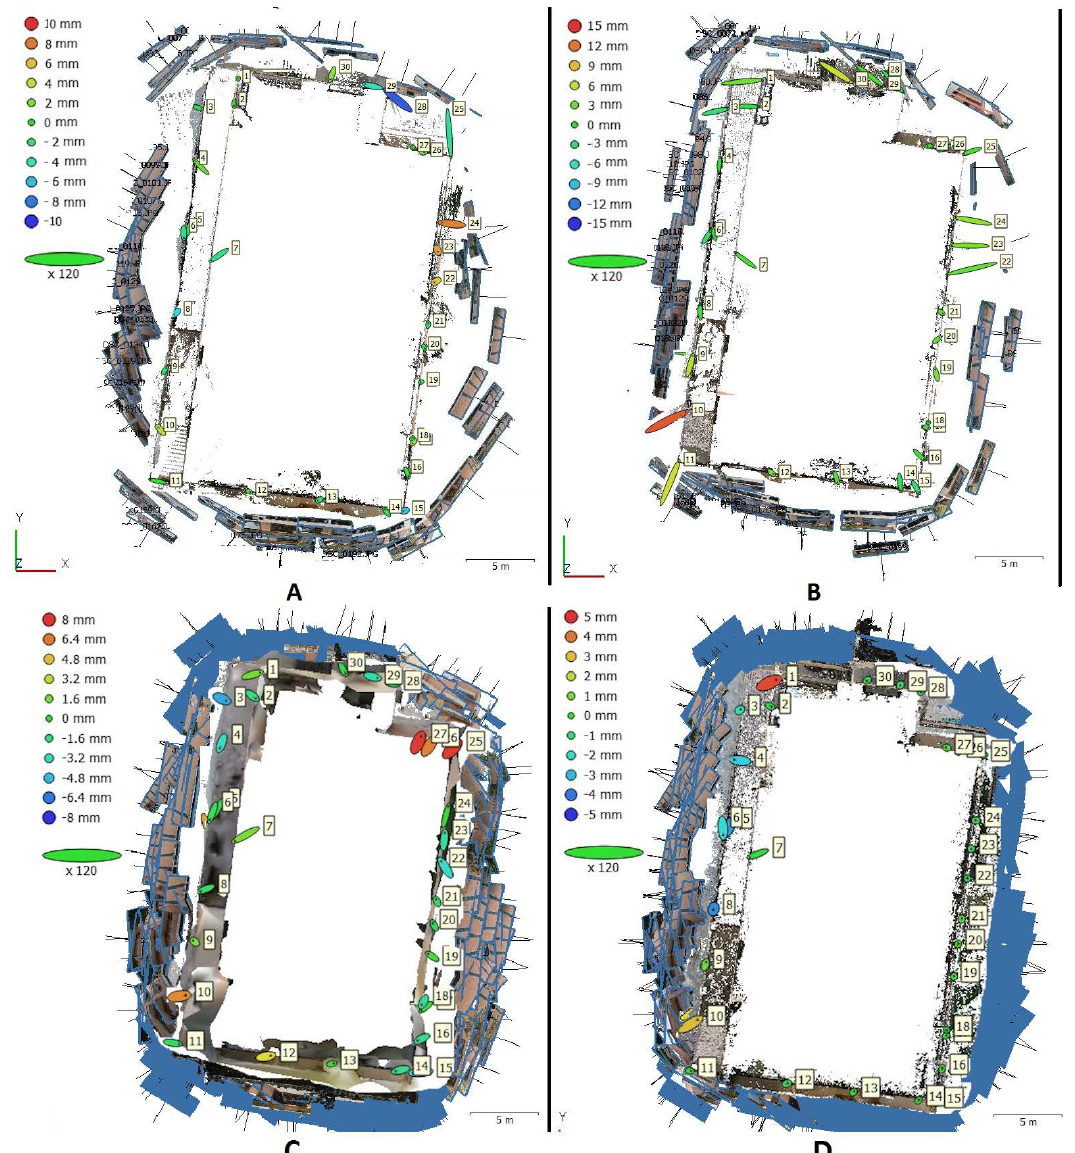
Figure 22. The four recovered image networks for centre pointing ( A ), façade pointing ( B ), hybrid ( C ) and centre & façade datasets ( D ). The error ellipsoids of GCPs, also demonstrated through the colourful ellipses to the left side of the building. For better visualization, the scale of the ellipses is multiplied by